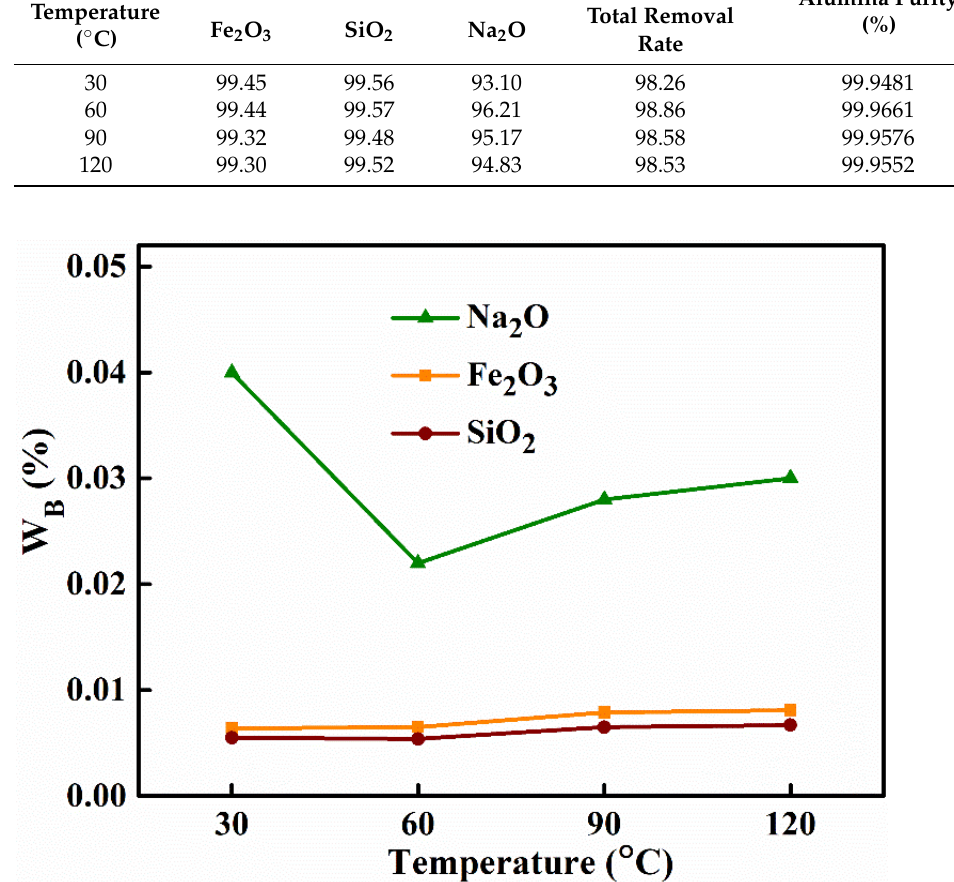
Figure 2. Effect of aging temperature on the impurity mass ratio in the product alumina.